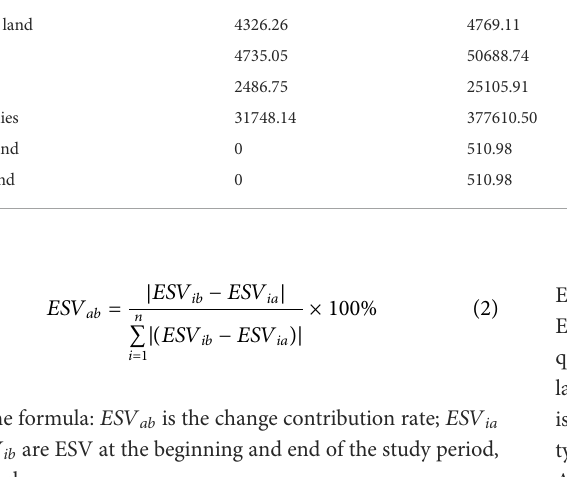
TABLE 1 Value of ecosystem services per unit area in Jiangjin (RMB/hm 2 /year). Category of